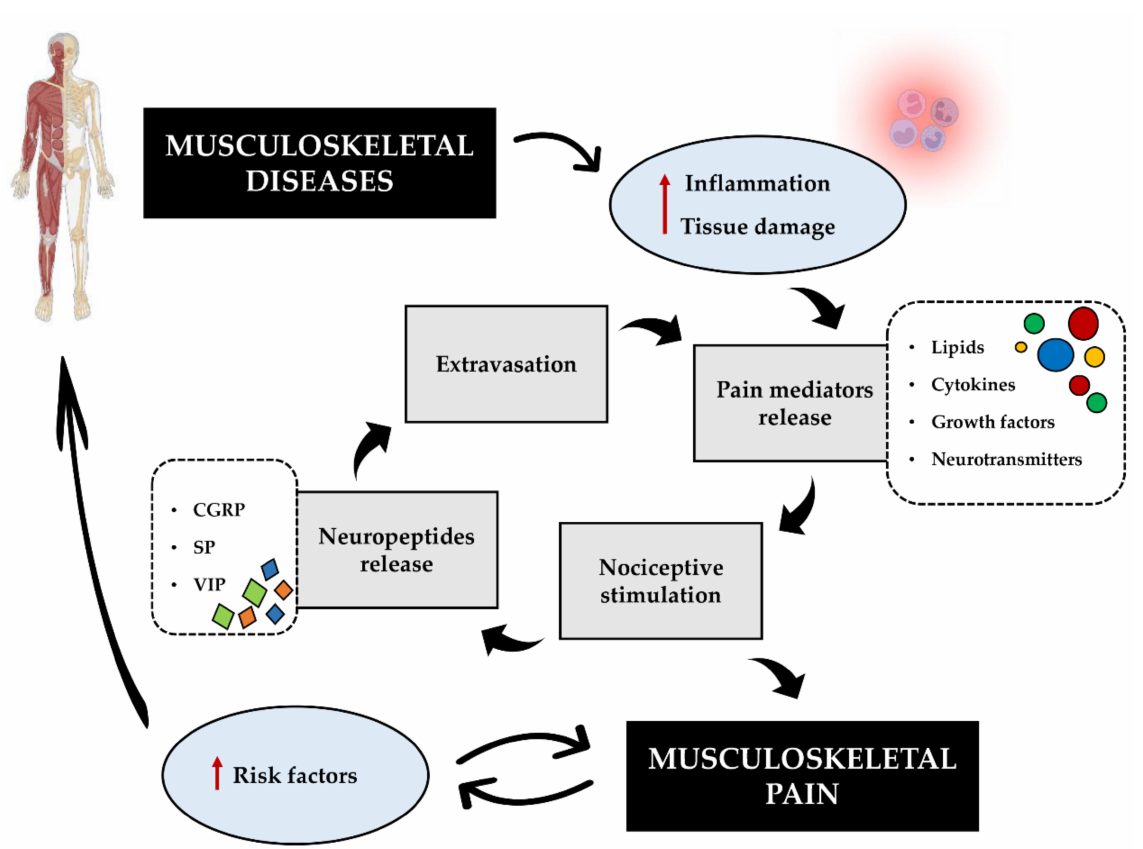
Figure 3. Musculoskeletal pain cycle. Some musculoskeletal disorders are characterised by an increased inflammatory state and tissue damage, which leads to the release of chemical mediators responsible for the nociceptive response. Consequently, the release of neuropeptides such as calcitonin gene-related peptide (CGRP), substance P (SP), and vasoactive intestinal peptide (VIP) occurs, with a potent vasodilatory action that promotes the extravasation of immune cells to the site of damage. In a pathological context, this chain of events takes on the characteristics of a vicious circle leading to prolonged nociceptive stimulation. The resulting musculoskeletal pain leads to the exacerbation of important risk factors, such as sedentariness and depression, which not only promote musculoskeletal pain but also exacerbate the pathological state by promoting the reinforcement of the